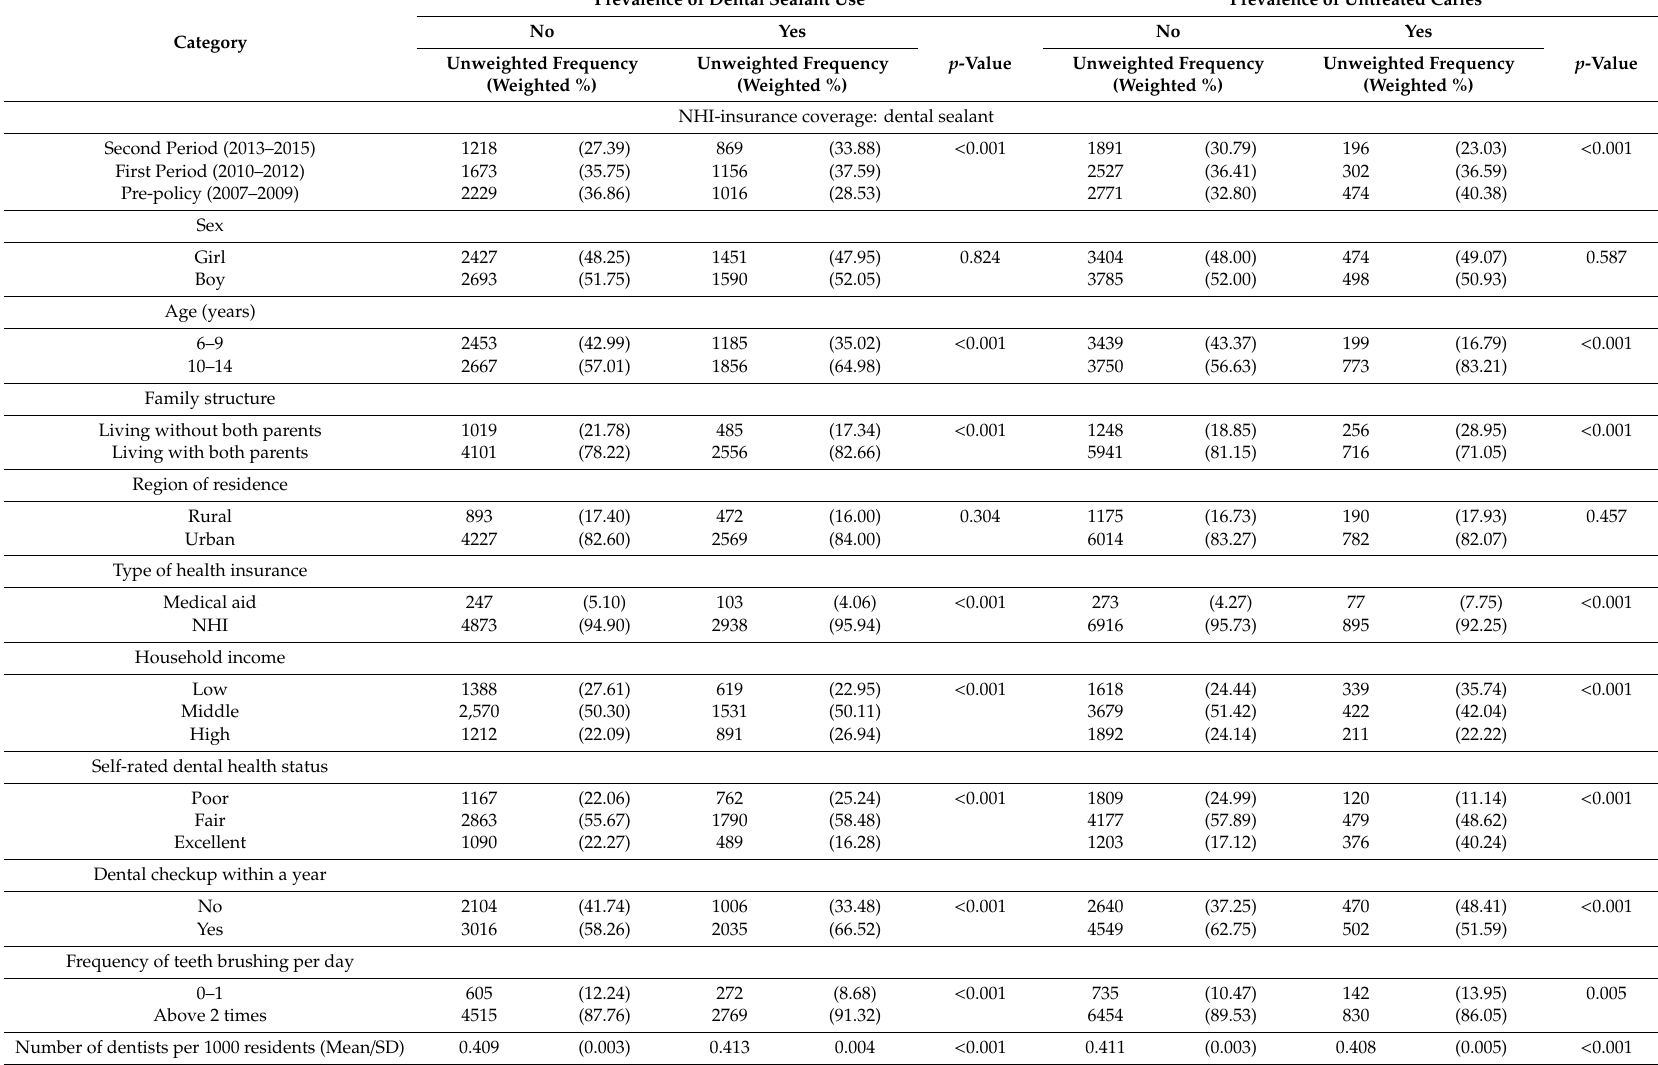
Table 2. Changes in the outcome variables over time by